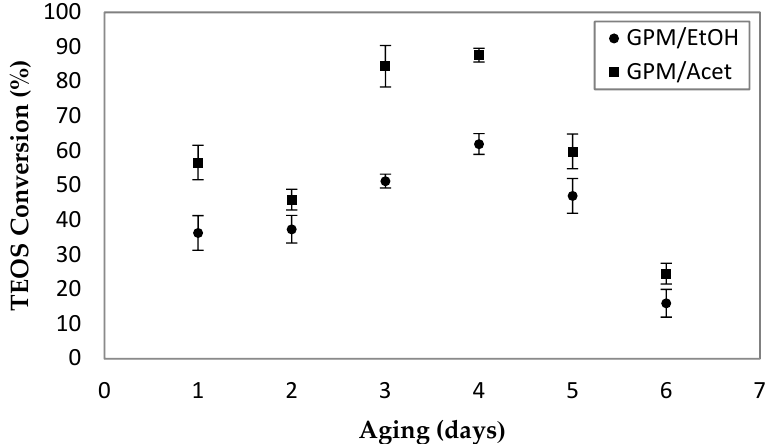
Figure 4. The effect aging time of aluminum hydroxonitrate solution on the conversion of TEOS. For each powder, emulsion two was sonicated for 30 min; all of the other synthesis parameters are provided in Table 1. Table 3. The effect of the sonication time of emulsion two on the TEOS conversion. Aqueous solution was aged for four days in each case; all of the other synthesis parameters are provided in Table 1.